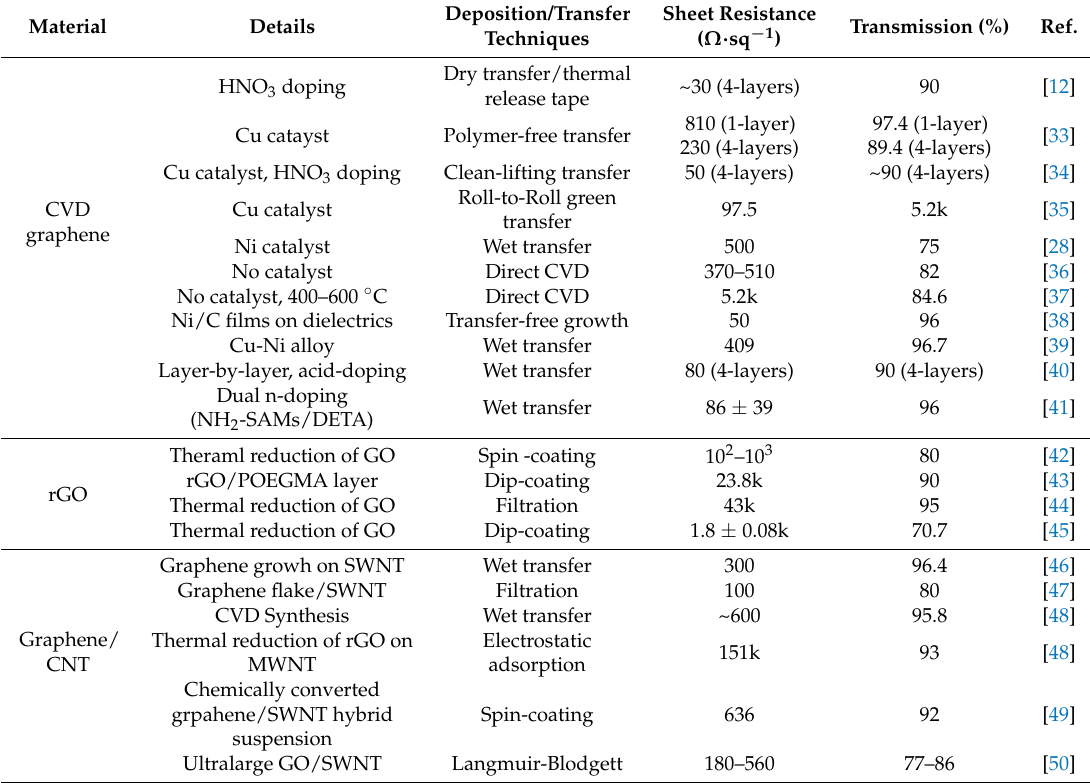
Table 1. The performance of transparent conducting electrodes (TCEs) based on graphene-related materials. CVD–chemical vapor deposition, DETA–diethylenetriamine, rGO–reduced graphene oxide, CNT–carbon nanotubes, SWNT–single-walled carbon nanotubes, MWNT–multi-walled carbon nanotubes, NW–nanowire, GP–Graphene, PEDOT:PSS–poly(3,4-ethylenedioxythiophene) polystyrene sulfonate, ITO–indium tin